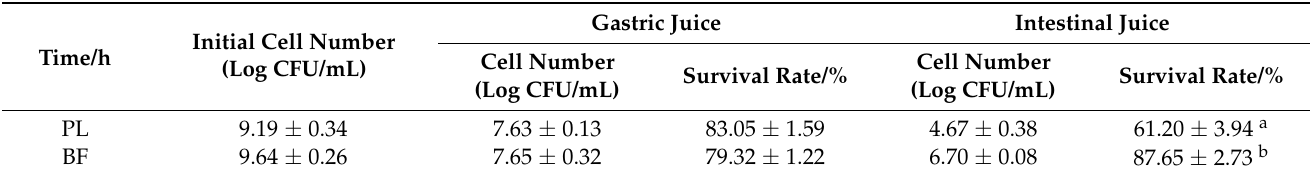
Table 1. Tolerance to artificial gastric and intestinal conditions of L. plantarum Y42 in the biofilm (BF) and planktonic (PL) states; p < 0.05. All data are presented as mean ± SD. Different small capital letters are presented as significantly different ( p < 0.05).